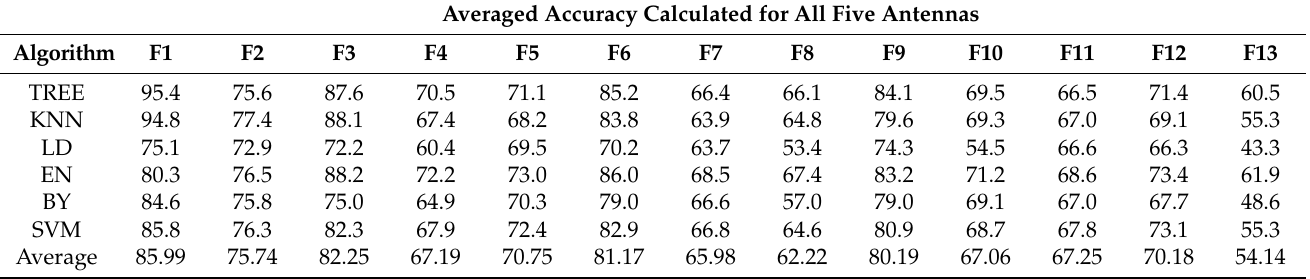
Table 4. Summary of averaged accuracy for five antennas for each feature applied